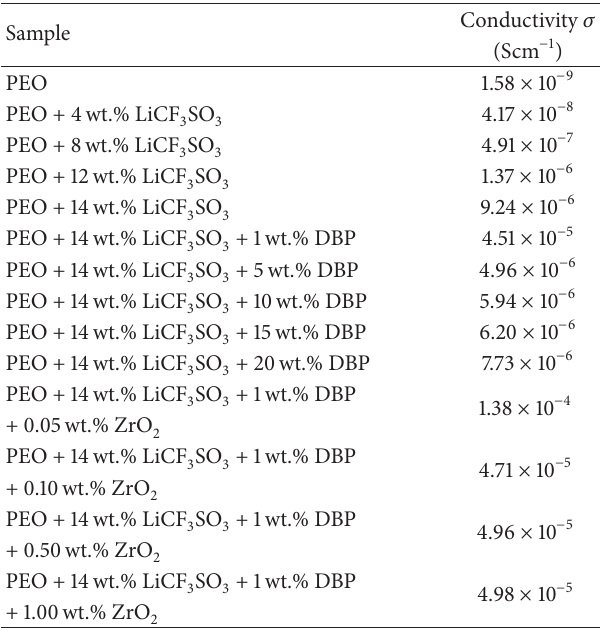
Table 1: Conductivity values of SPE at ambient